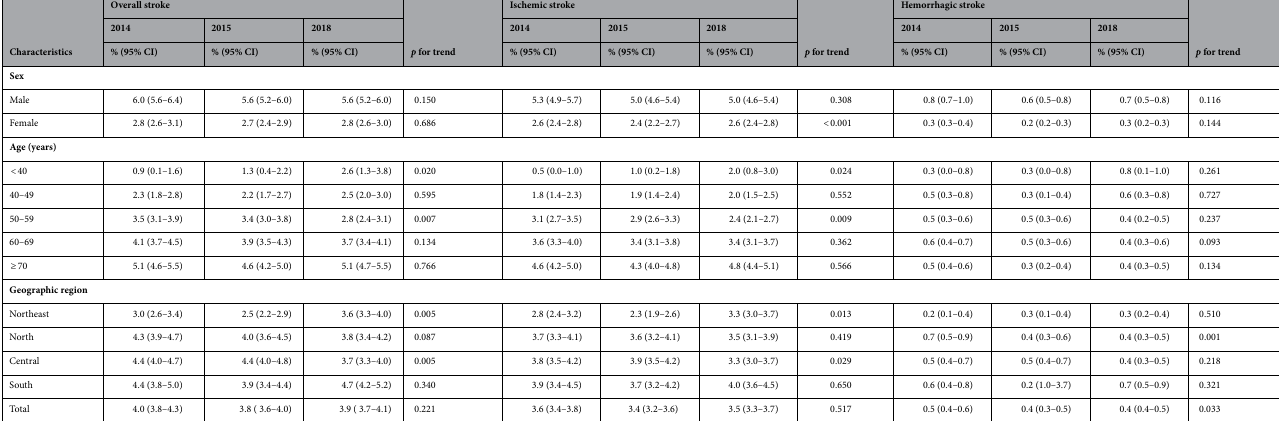
Table 2. The trends in the prevalence of overall, ischemic, and hemorrhagic strokes among Thai patients with hypertension over the period from 2014 to 2018. The p for trend is calculated using the chi-square test for trend and the level of statistical significance is set at p for trend <